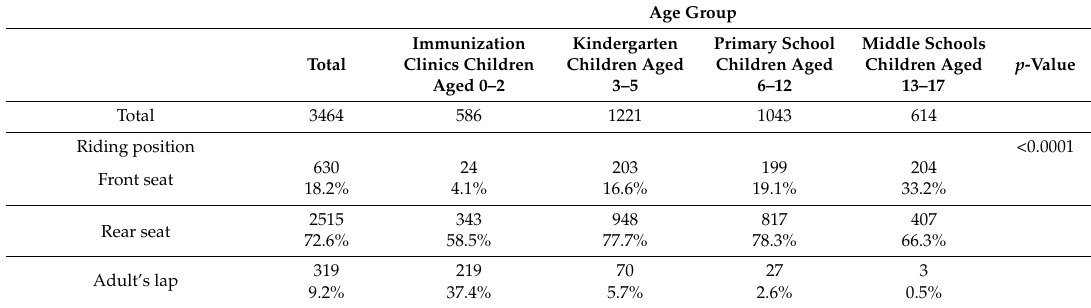
Table 1. Observed child riding positions and restraint use of child passengers by age group ( n